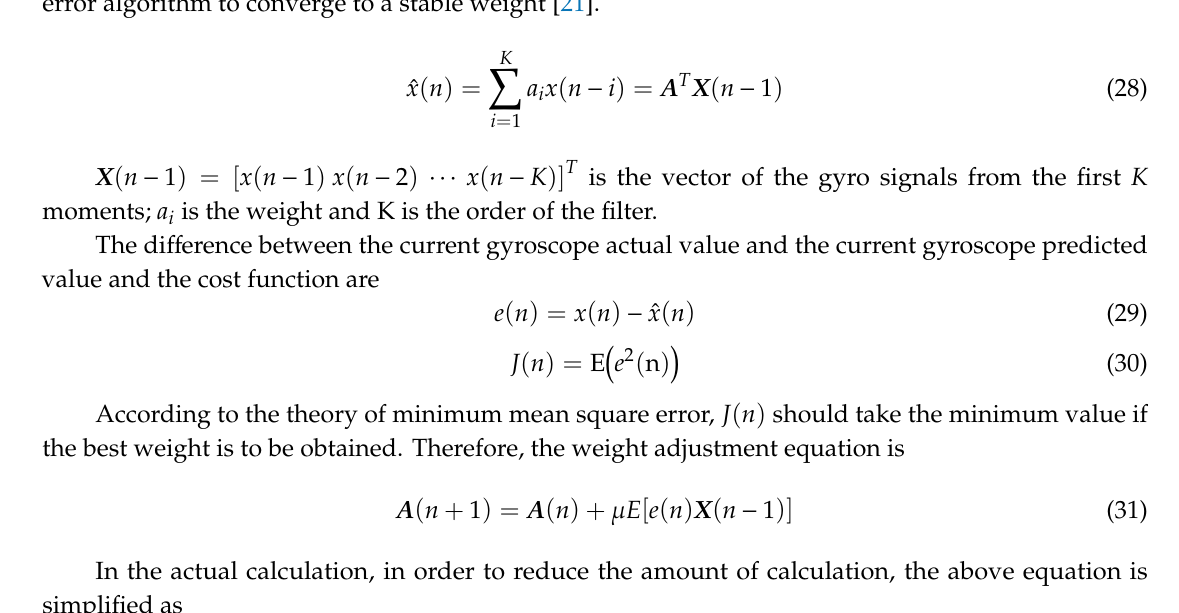
Figure 5. The angular velocity signal after filtering by the Kalman algorithm.